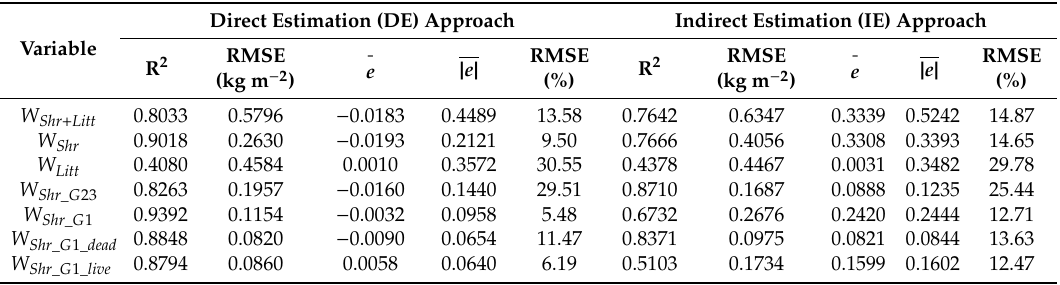
Table 6. Goodness-of-fit statistics obtained with the direct estimation (DE) and indirect estimation (IE) approaches for each fuel